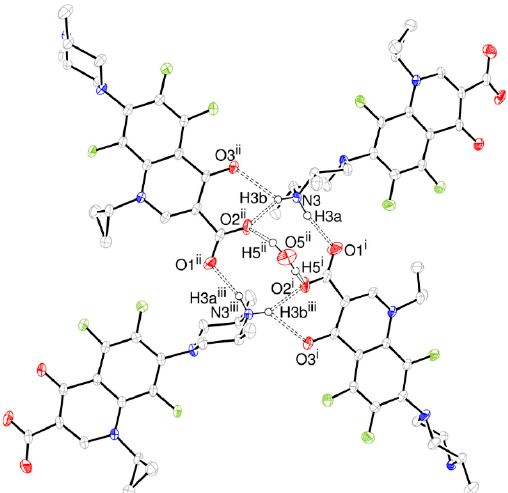
Figure 4. ORTEP-3 representation of the ORBI tetramer stabilized by hydrogen bonds (dashed line) viewed normal to the unit cell a axis. The hydrogen atoms not involved in the depicted hydrogen bonds were omitted for clarity. Symmetry codes: i –x + 1/2, y-1/2, –z + 3/2; ii –x + 1/2, –y + 1/2, z + 1/2; iii x, –y, –z + 2.